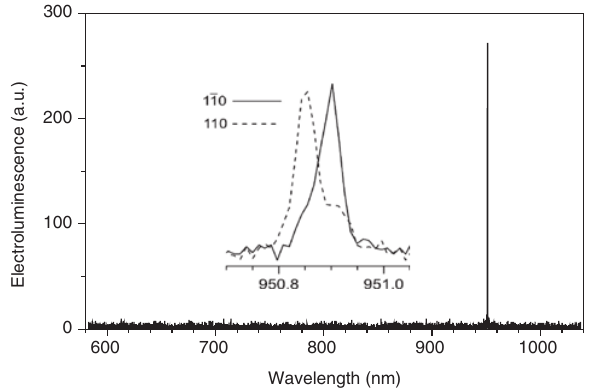
Figure 7: Emission of an electrically driven q-bit (single photon